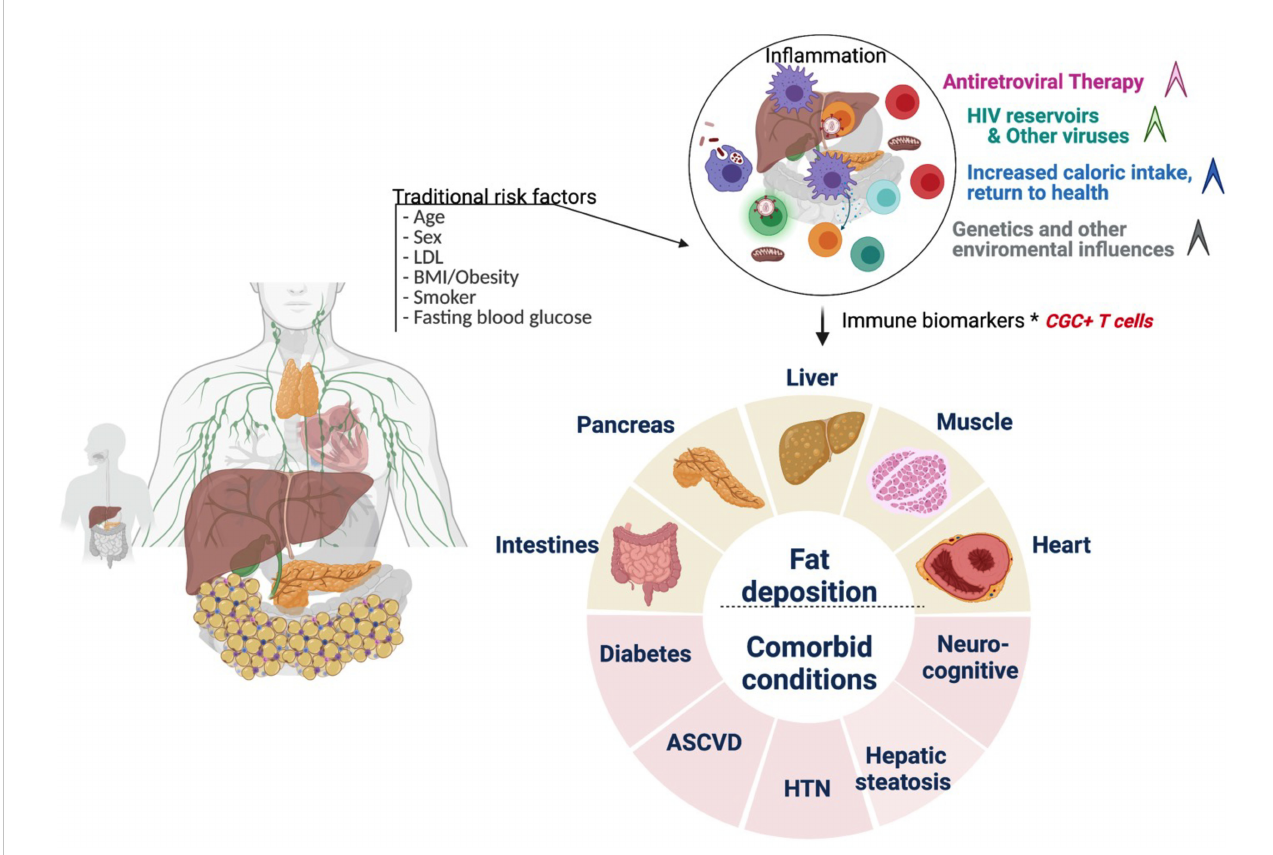
FIGURE 13 Conceptual Model. Traditional cardiovascular risk factors (age, sex, low density lipoprotein, body mass index, smoking status, and fasting blood glucose) and HIV-associated factors antiretroviral therapy, viral load, and CD4 + T cell count) may contribute to in fl ammation that drives cardiometabolic disease. CGC + CD4 + T cells are largely CMV-speci fi c T cells that are in fl ated in PWH and may have a diagnostic and mechanistic role in the pathogenesis of cardiometabolic disease. Figure created using